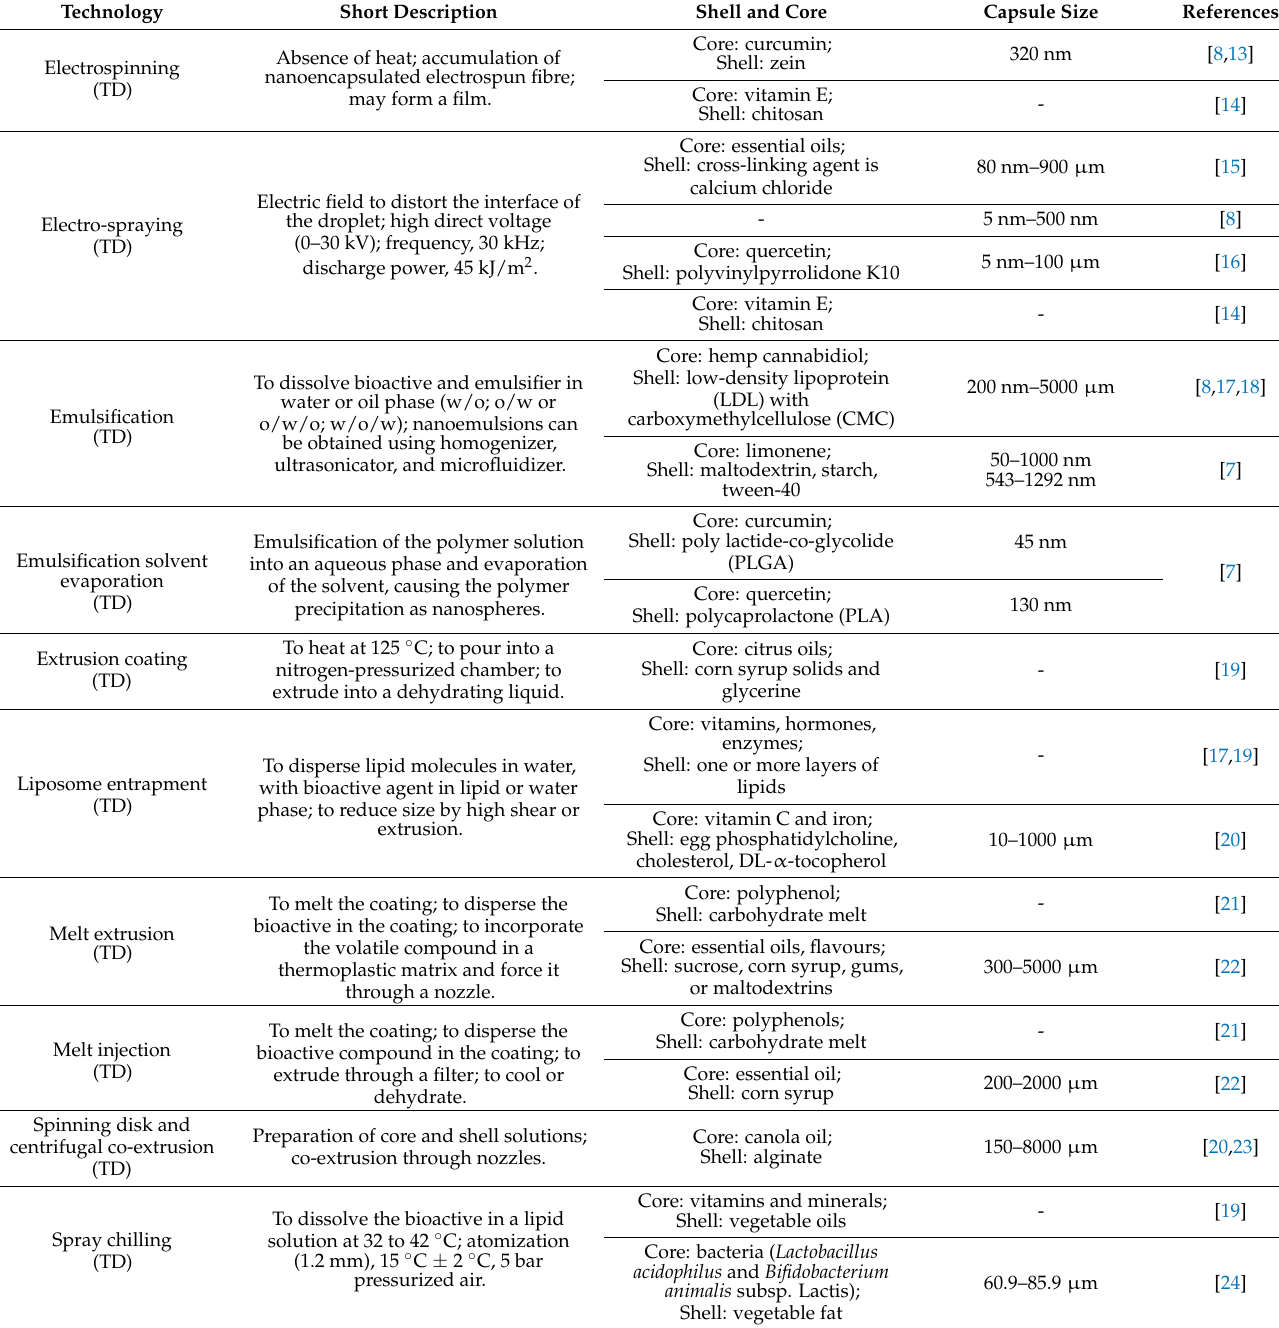
Table 1. Micro- and nanoencapsulation